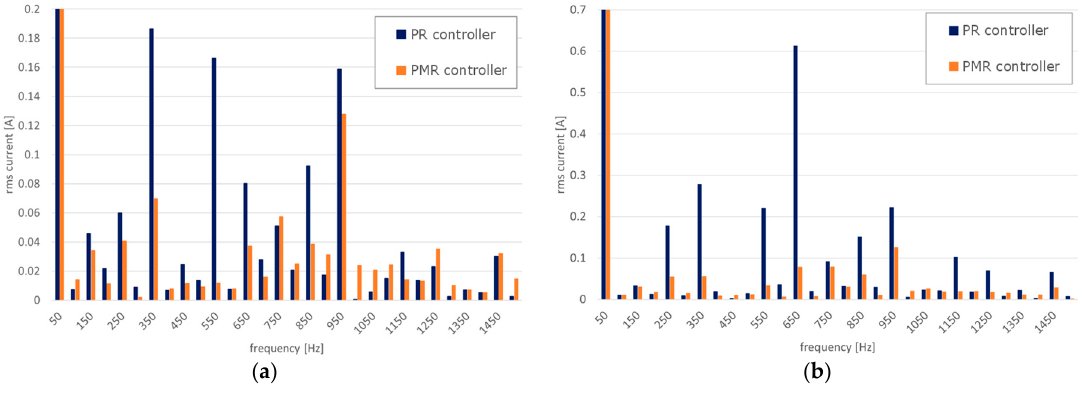
Figure 16. Current harmonics: ( a ) Scenario 1; ( b ) Scenario 2. Table 3. Harmonic current distortion obtained with the different control strategies. Voltage Distortion